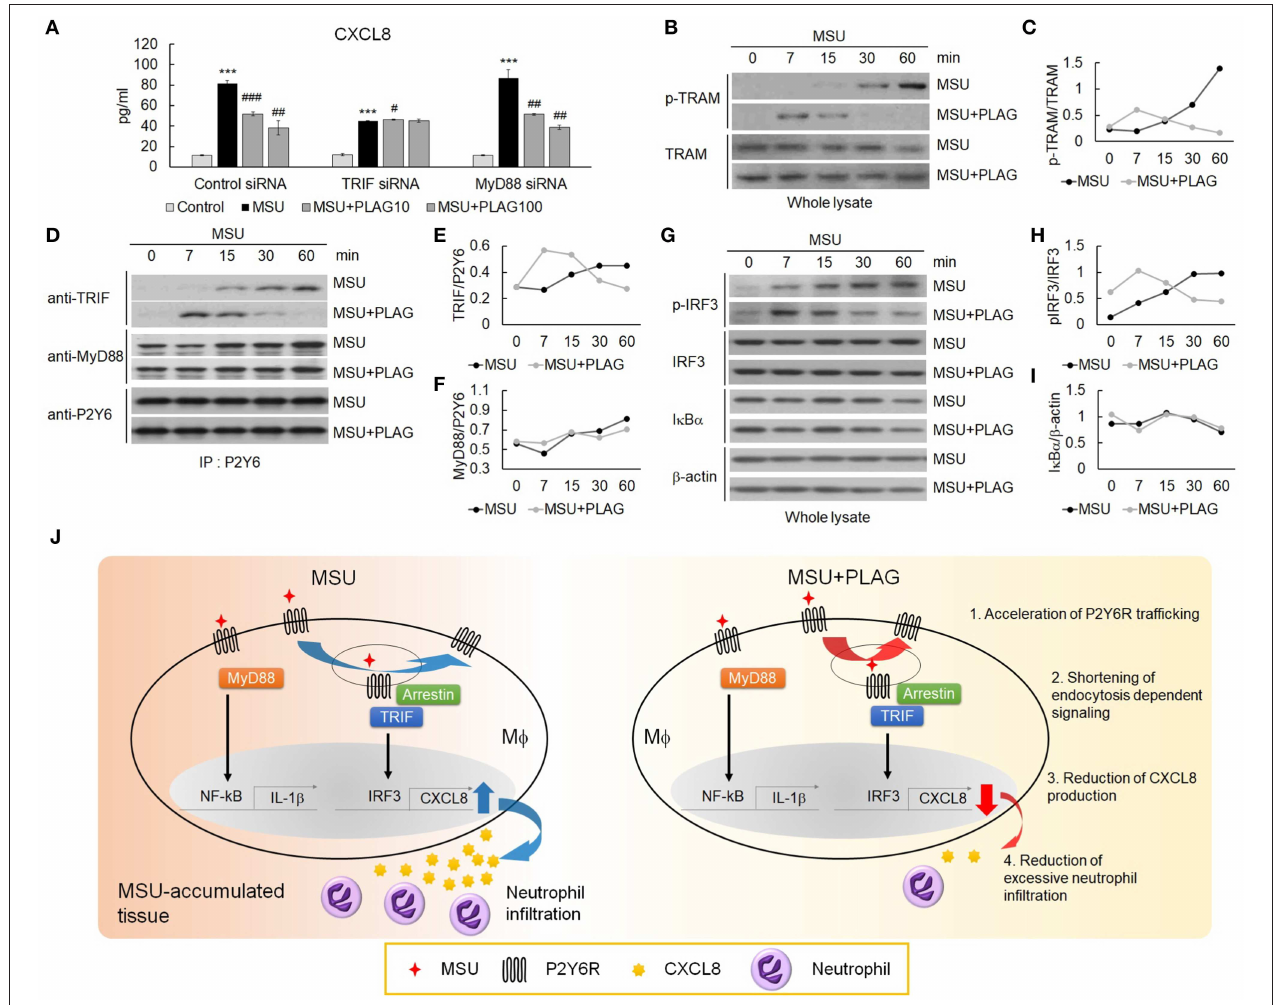
FIGURE 6 | The reduction of CXCL8 expression by PLAG is dependent on TRIF/IRF3 signaling. (A) THP-1 cells were transfected with TRIF and MyD88 siRNA. After 24h, the cells were incubated with 100 µ g/ml PLAG or DMSO for 1h. The cells were then treated with 200 µ g/ml of MSU crystals for 24h. The culture supernatants were harvested and assayed using ELISA to check the secreted levels of CXCL8. (B) THP-1 cells were incubated with 100 µ g/ml PLAG or DMSO for 1h and were stimulated with 200 µ g/ml MSU crystals for 7, 15, 30, and 60min. Whole lysates were used to analyze the phosphorylation of TRAM. TRAM was used as the loading control. (C) Quantification of (B) . (D) TRIF signaling during trafficking was evaluated in THP-1 cells. Cells were incubated with 100 µ g/ml PLAG or DMSO for 1h and were stimulated with 200 µ g/ml of MSU crystals for 7, 15, 30, and 60min. Cell lysates were immunoblotted with TRIF and MyD88 antibodies after immunoprecipitation with the P2Y6 receptor antibody. (E,F) Quantification of (D) . (G) Whole lysates were used to analyze the phosphorylation of IRF-3 or I κ B α degradation. β -Actin was used as a loading control. (H,I) Quantification of (G) . (J) A schematic diagram showing the mechanism of action of PLAG. PLAG promotes MSU-induced P2Y6 receptor intracellular trafficking (1) and reduces the duration of endocytosis-dependent signaling (2). Consequently, PLAG reduces MSU-induced CXCL8 production (3) and prevents excessive neutrophil recruitment into MSU-accumulated tissue (4). Data are presented as mean ± SD. *** p < 0.001, compared to the control group. # p < 0.05, ## p < 0.01, ### p < 0.001, compared to the MSU-treated group.